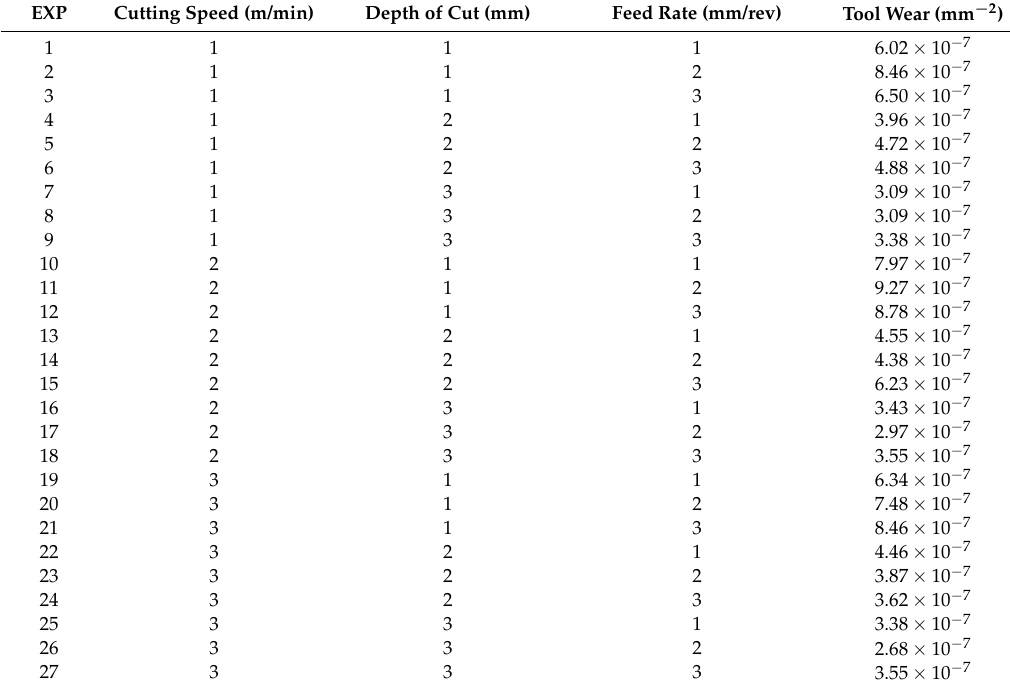
Figure 8. Digital microscope (SONY color video camera). Table 6. Experiment orthogonal array.